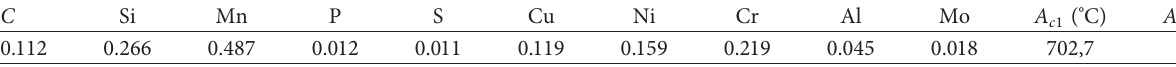
c 1 and A c 3 temperature of the steel.